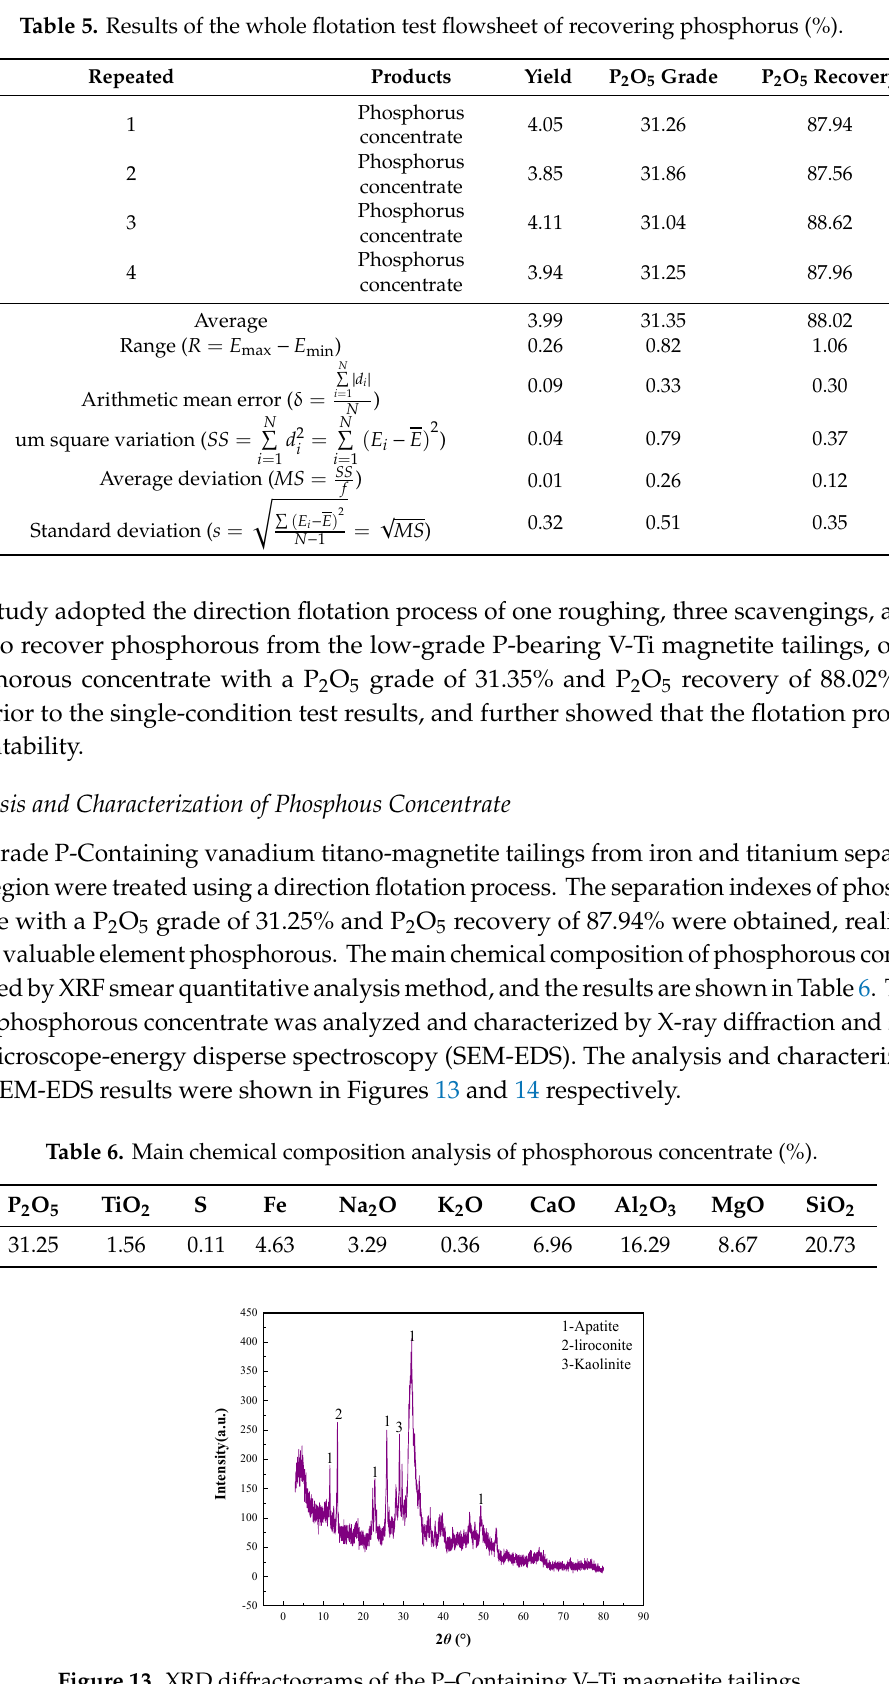
Figure 14. SEM-EDS images of apatite ( a ), olivine ( b ), and feldspar ( c ).